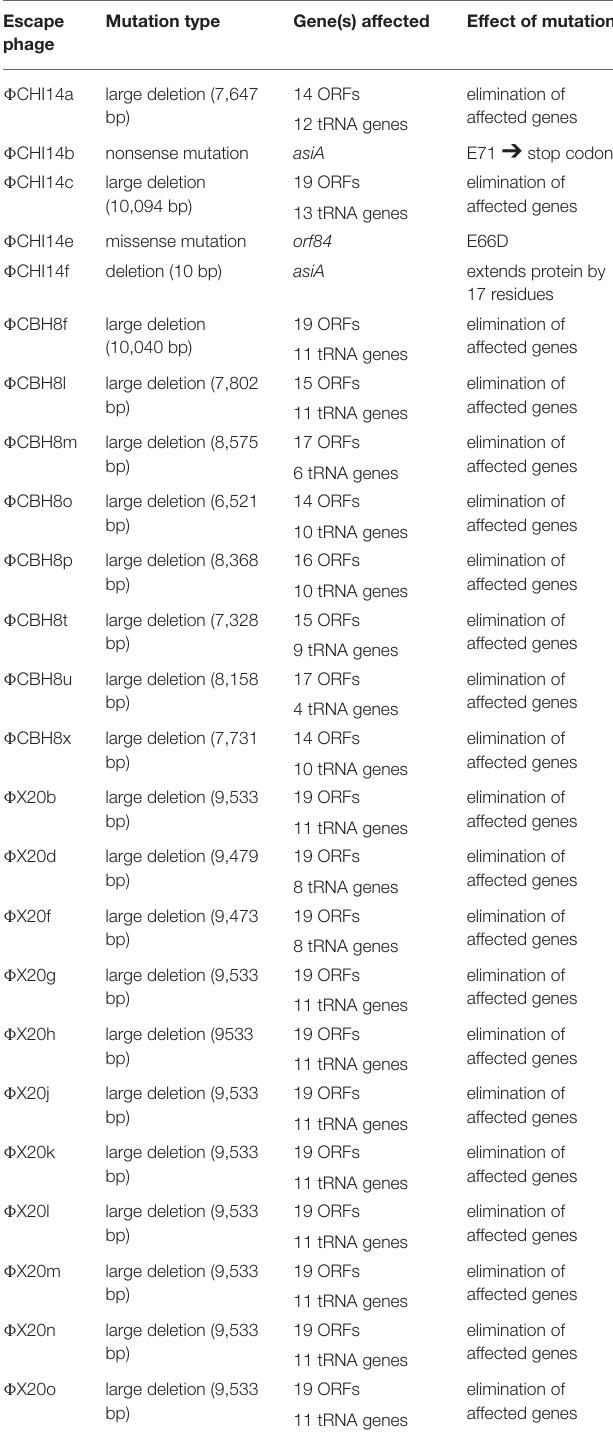
TABLE 2 | Summary of mutations in 8 CHI14, 8 X20, and 8 CBH8 ToxIN Pa escape mutants. Escape